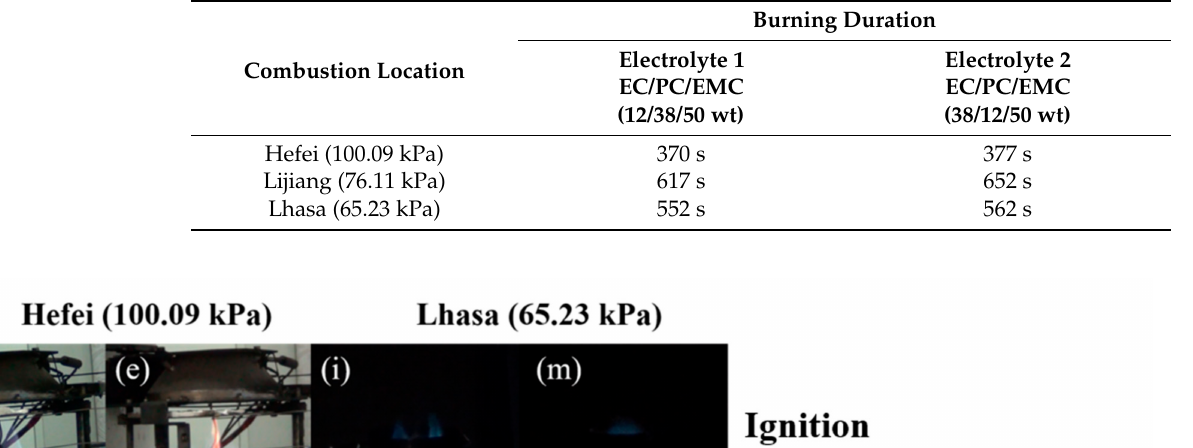
Table 3. Comparison of burning duration of two electrolytes in Hefei, Lijiang and Lhasa.